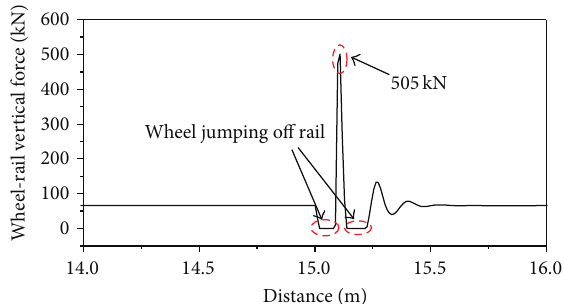
Figure 14: Wheel-rail vertical force in time domain.